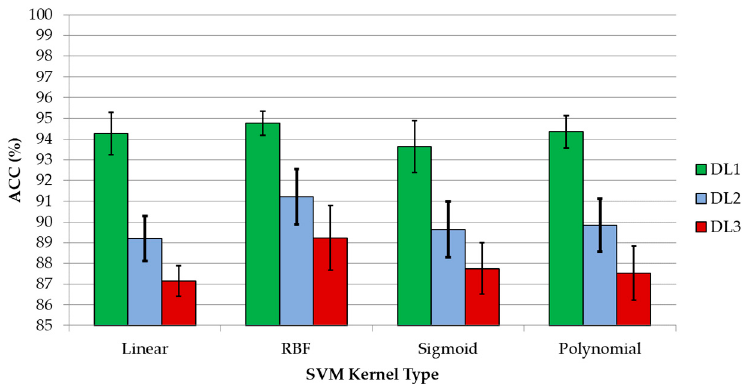
Figure 4. Average and standard deviation of the overall accuracy results achieved with the optimal hyperparameters for each kernel type and discrimination level.